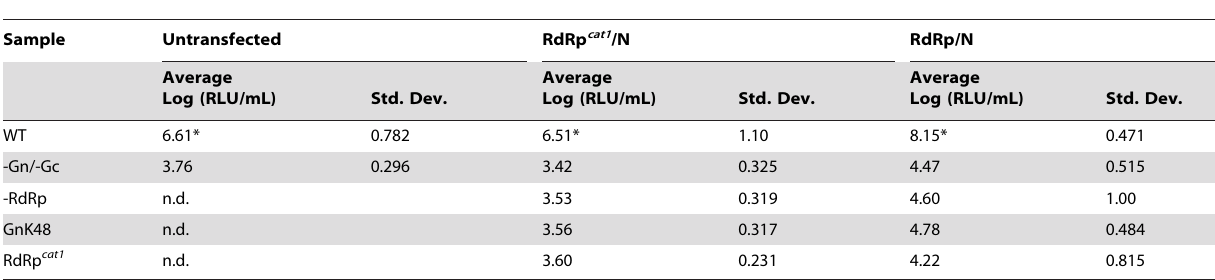
Table 1. RdRp and N in trans fail to rescue RdRp-deficient RVF-VLPs.